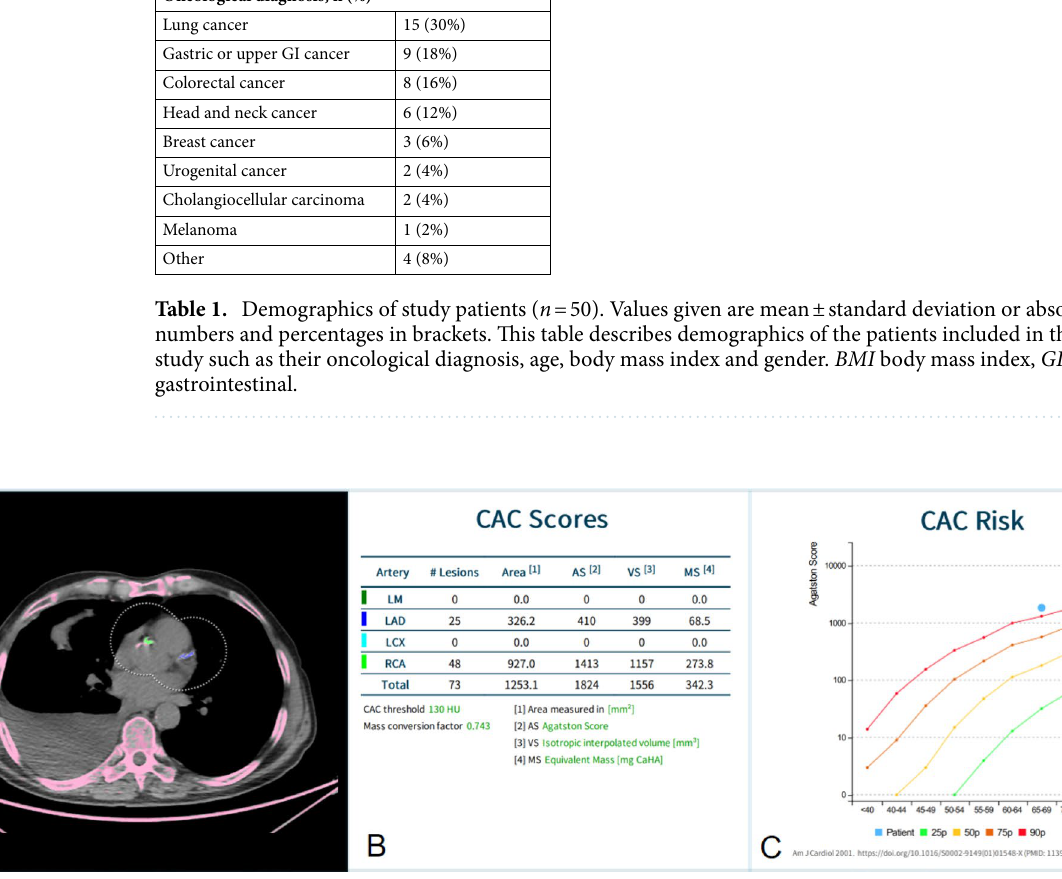
Figure 2. Representative CT image with automated deep learning coronary artery calcium scoring. Representative CT images of a 68-year-old man with a body mass index of 21.8 kg/m 2 with severe coronary artery calcifications (i.e., Agatston score of 1616). Images from ungated non-contrast CT from 18F-FDG-PET/ CT for staging of lung cancer ( A ), including fully automated deep learning coronary artery calcium scoring (DL-CACS) markings. Coronary calcifications in the left main (LM), left anterior descending (LAD), left circumflex artery (LCX), and right coronary artery (RCA), were correctly quantified ( B ) by the AI-CACS tool, resulting in a total score of 1824. The DL-CACS correctly attributed the highest CAC risk ( C ).